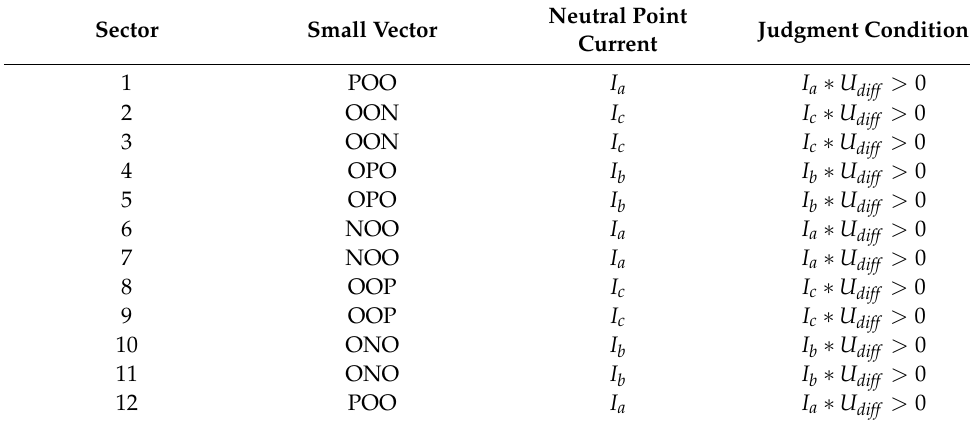
Table 4. Details of neutral point voltage control in each